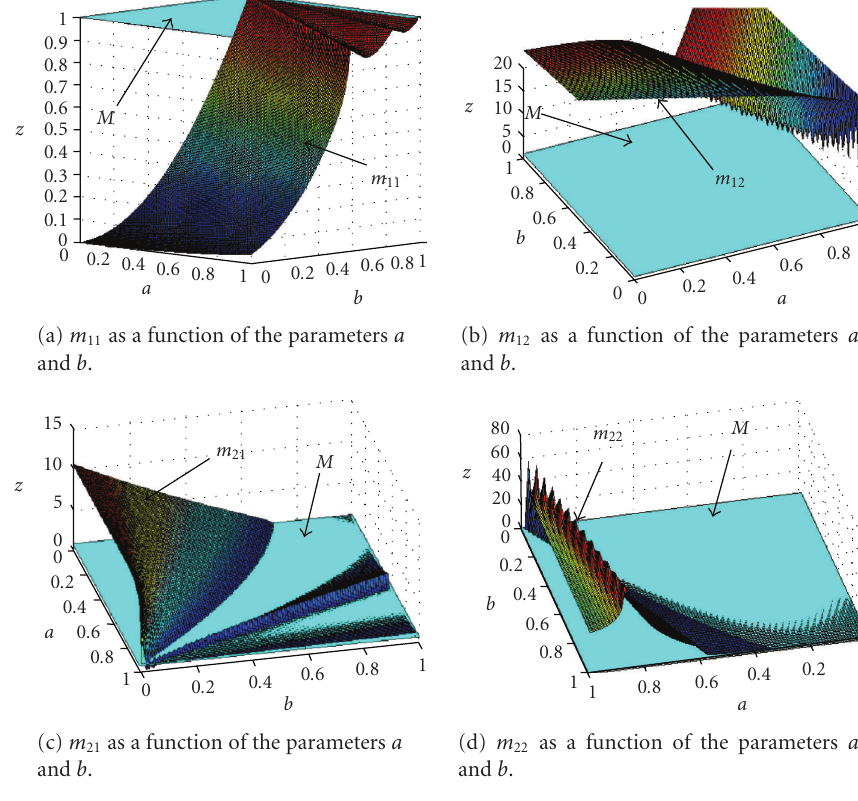
Figure 2.1. The modules of the